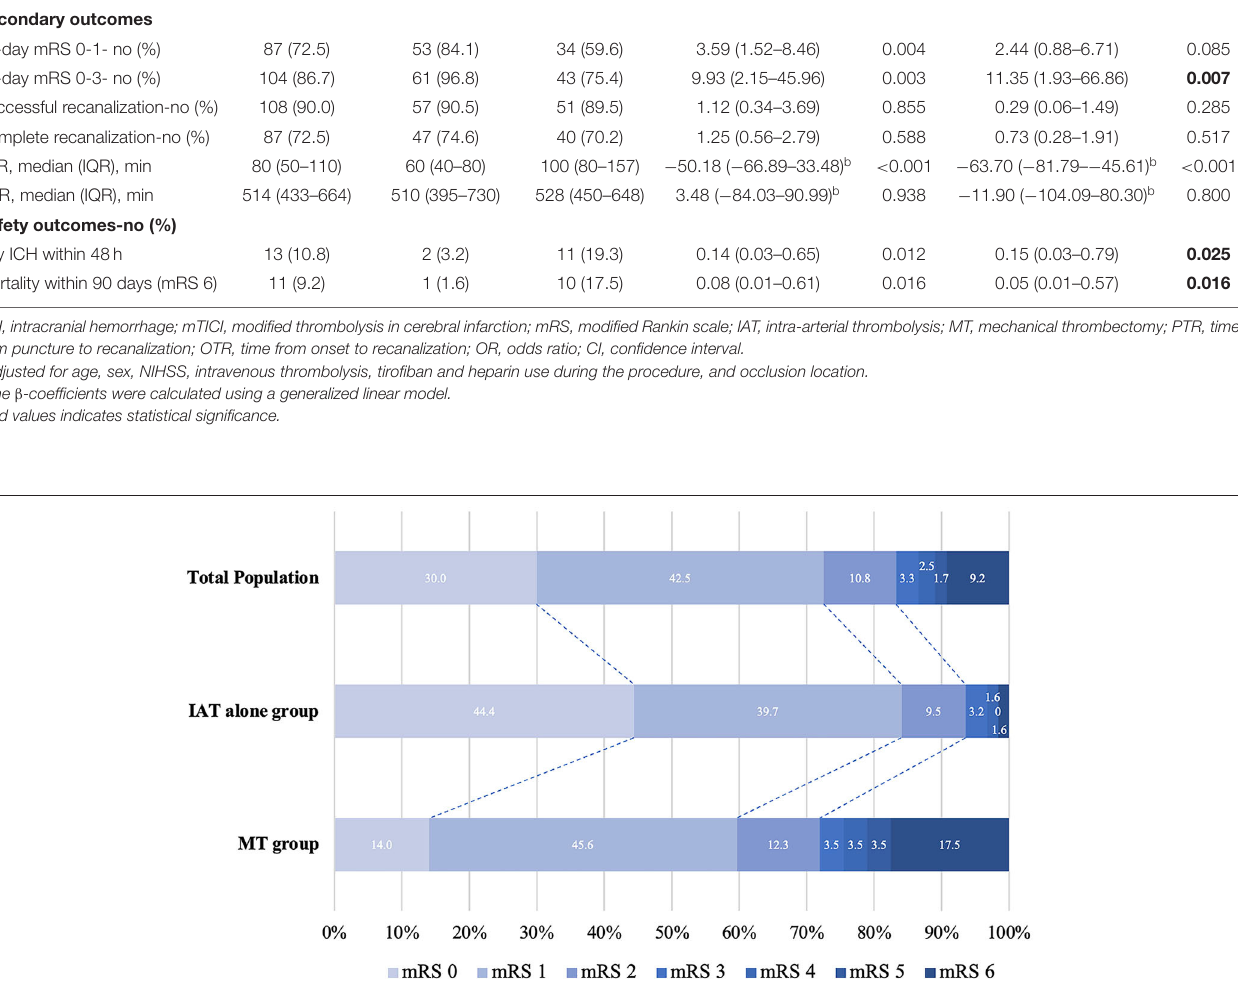
FIGURE 2 | Distribution of modified Rankin Scale (mRS) scores at 3 months between IAT alone and MT group. MT, mechanical thrombectomy; IAT, intra-arterial thrombolysis; NIHSS, National Institutes of Health Stroke Scale score; mRS, modified Rankin scale.